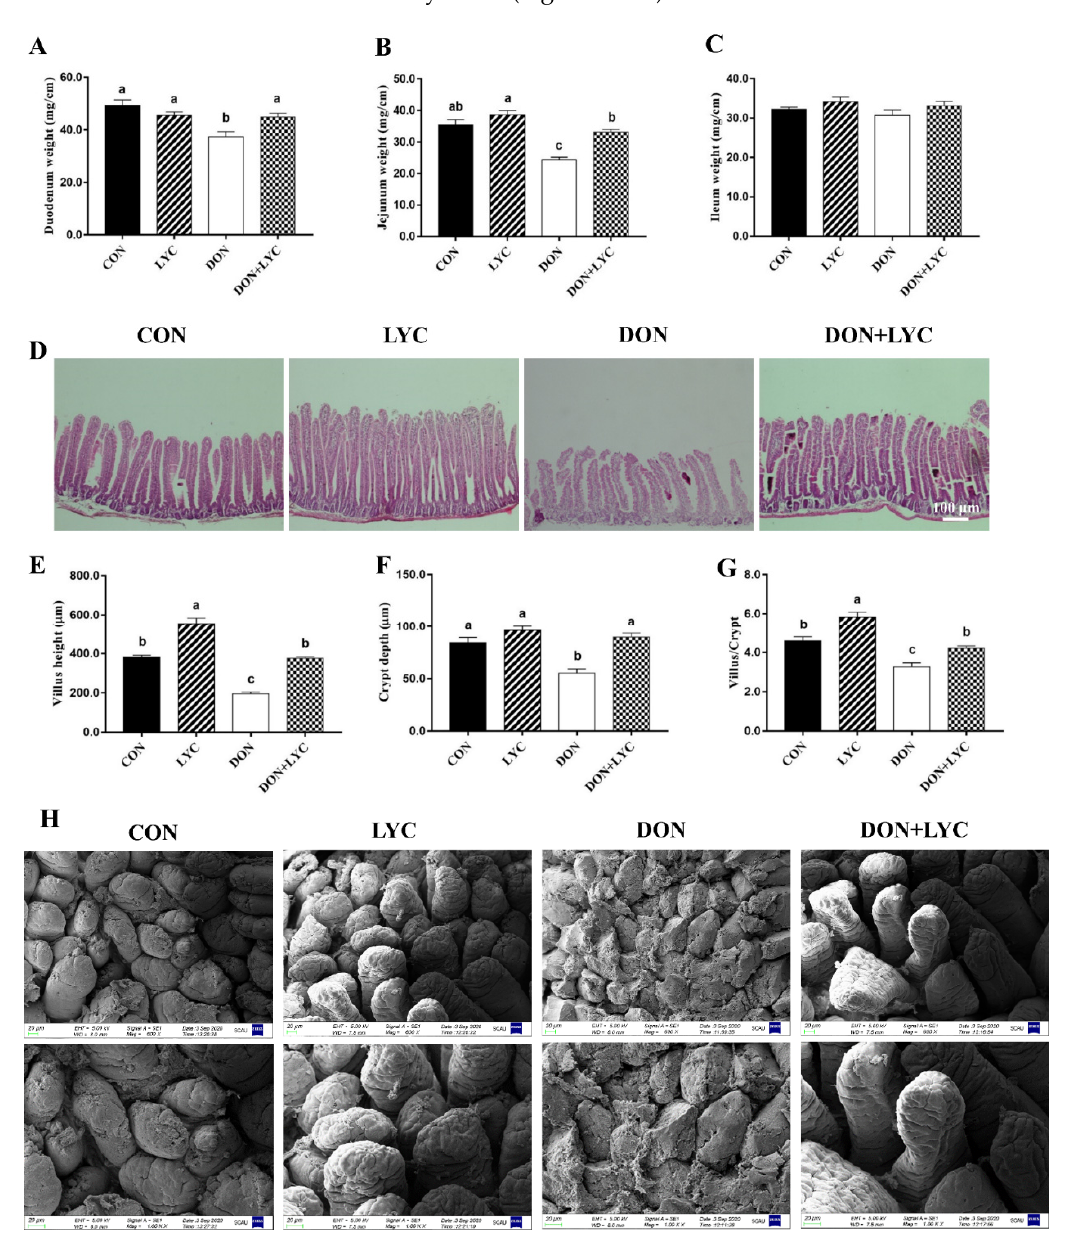
Figure 2. Lycopene treatment repairs intestinal epithelium injury of mice exposed to DON. ( A ) Duodenum weight ( B ), jejunum weight, and ( C ) ileum weight. Results are expressed as mean ± SEM ( n = 6). ( D ) Hematoxylin and eosin (H&E) staining in the jejunum. ( E ) Villus height, ( F ) crypt depth, and ( G ) ratio of the villus to the crypt. The results are presented as mean ± SEM ( n = 3). ( H ) Represented images of scanning electron microscopy in the jejunum of mice (600× and 1000×). Columns with different superscripts letters indicating significant difference ( p < 0.05).